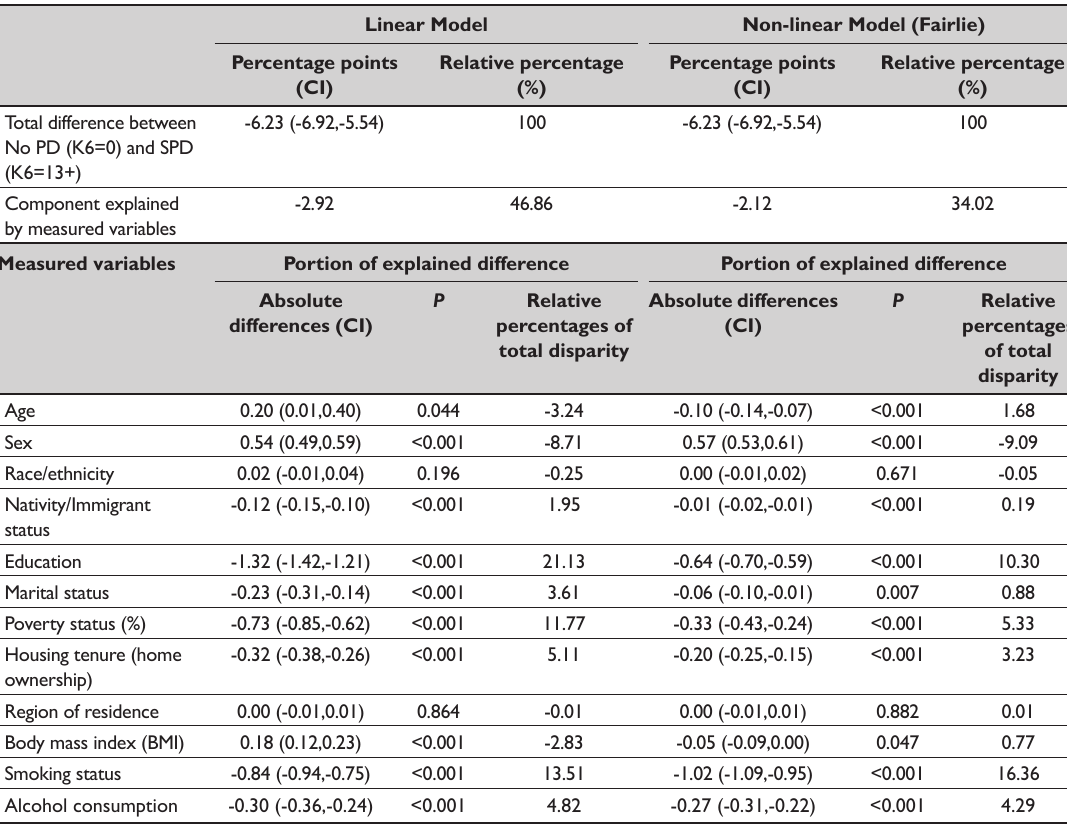
Table 3: Fairlie non-linear decomposition results for disparities in all-cause mortality between adults without psychological distress and with serious psychological distress,